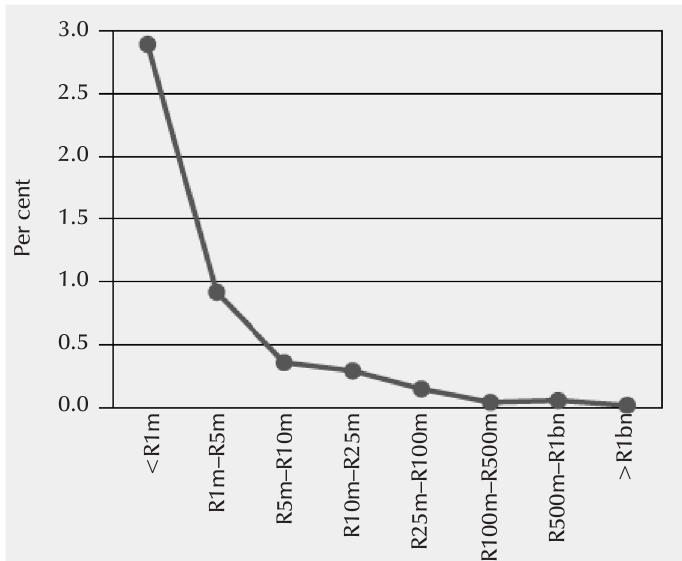
Annual cost of tax compliance as a percentage of turnover